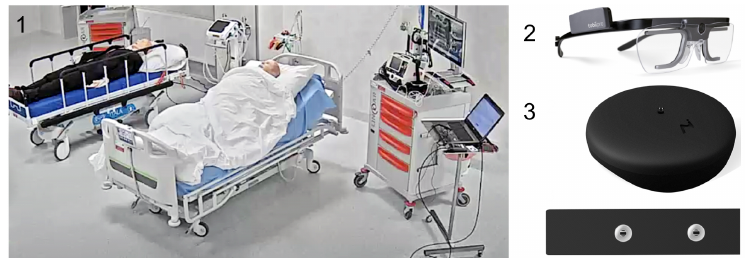
Figure 2. Experimental stand. 1 —Composed of a bed on which a phantom (patient) lies, a cardiac monitor (Terra Monitor), 2 —Tobii Eye Tracker Glasses 2 [18] with a laptop recording data, and 3 —the wearable chest belt for EEG signal recording (AidLab) [19]. The stand is located in the Medical Simulation Center of Collegium Medicum of the University of Zielona Gora.